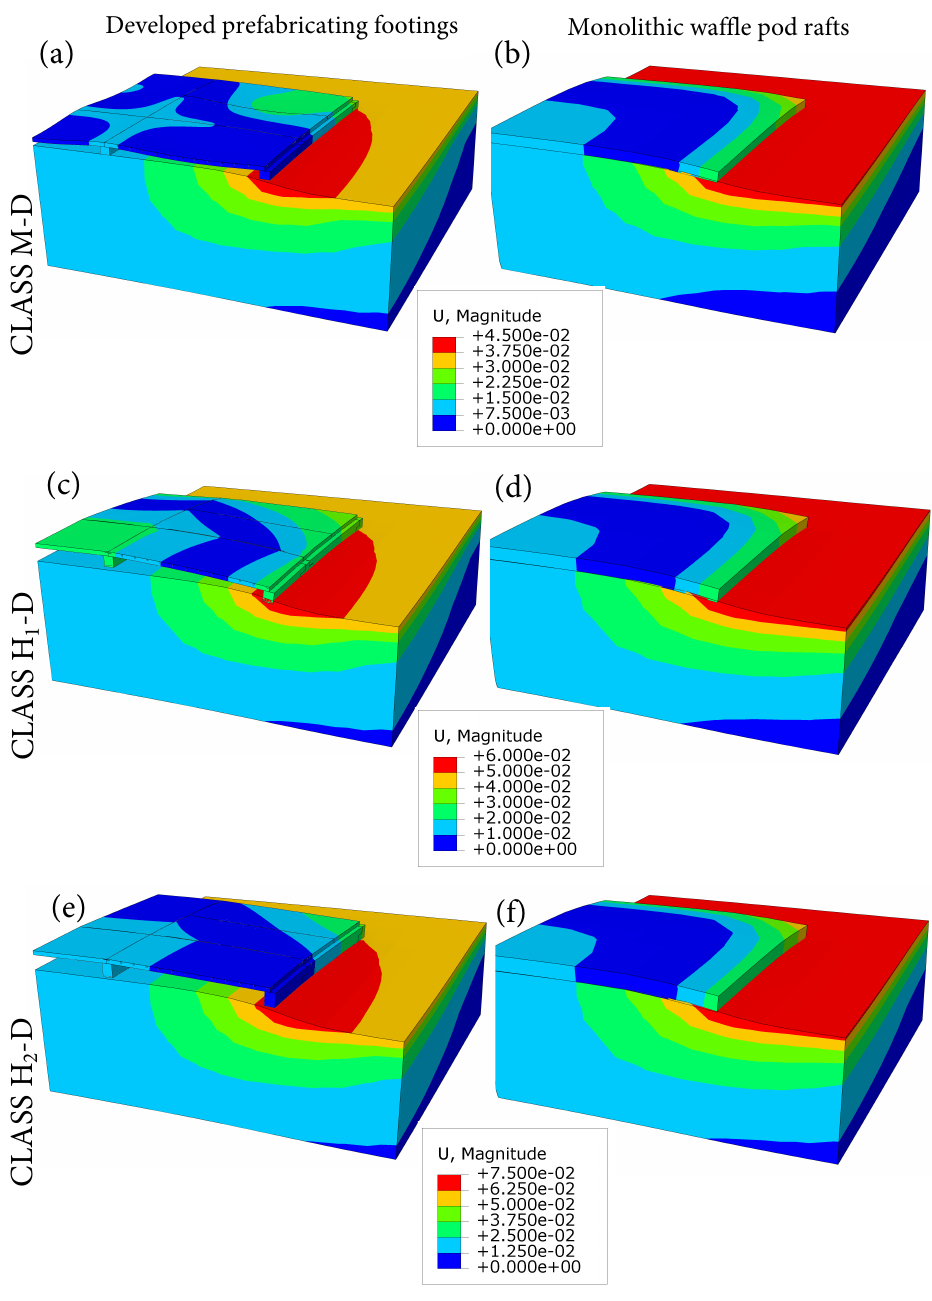
Figure 7. Comparison of shrinking soil movement and footing deformation between the developed prefabricated footing systems and waffle rafts for ( a , b ) Class M-D soil, ( c , d ) Class H 1 -D soil, and ( e , f ) Class H 2 -D soil. Values of displacements are in